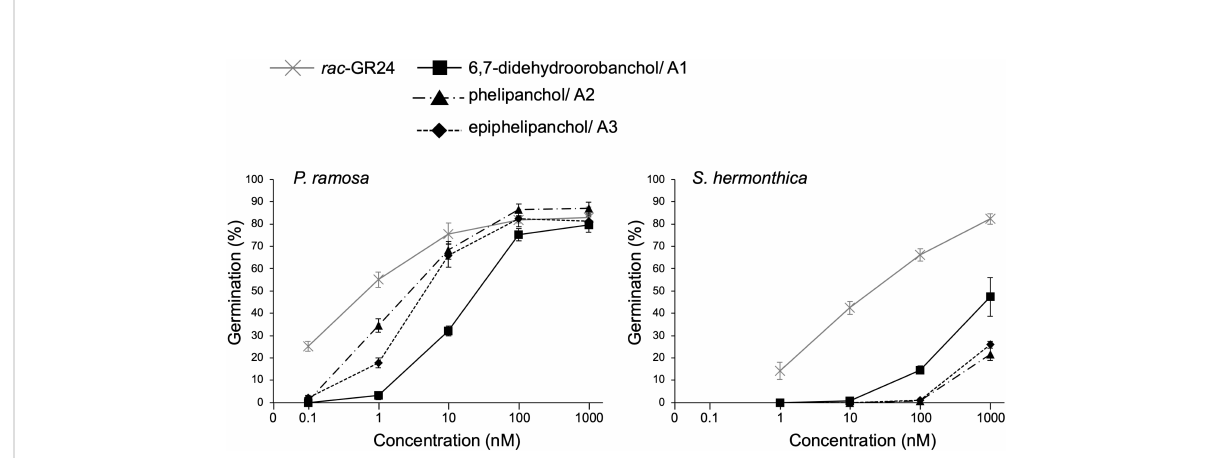
FIGURE 4 Germination-inducing activities of 6,7-didehydroorobanchol/A1, phelipanchol/A2, and epiphelipanchol/A3 isolated from tomato and synthetic SL analog rac -GR24 for P. ramosa and S. hermonthica . Data are presented as means ± SE ( n = 3).